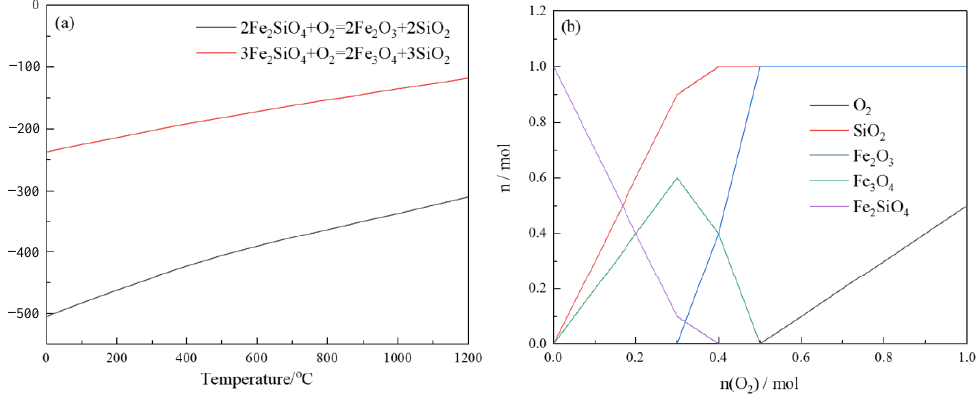
Figure 7. Gibbs free energy curves ( a ) and equilibrium diagram of Fe 2 SiO 4 decomposition ( b ). In order to separate and recover the Fe and iron from the roasted copper slag, alkali leaching of the core pellet was conducted. In the alkali leaching thermodynamics calcula- tion, the degradation amount of SiO 2 was set at 1 mol/kg, oxygen partial pressure was set as the X- axis, and NaOH addition was set as the Y-axis. As shown in Figure 8, when NaOH is added in a small amount, the equilibrium system consists of SiO 2 and NaOH solution, and there is no reaction at equilibrium; notably, the neglect of time in thermody- namics leads to the formation of H 4 SiO 4 in aqueous solution, which is not found in the actual experiment. With the NaOH gradual addition, part of Si reacts with it to form Na 2 Si 2 O 5 , which is completely transformed when the addition amount is 1.5 mol/kg. After addition of NaOH, the reaction products are divided into Na 2 SiO 3 and Na 2 Si 2 O 5 , and the constituents tend towards equilibrium due to the increase in sodium ion concentration. When the amount of NaOH is greater than 2.5 mol/kg, SiO 2 is completely transformed into Na 2 SiO 3 . Thermodynamic analysis shows that the silica-rich phase in roasting copper slag could be leached out by NaOH solution with a certain concentration, the iron-rich phase enters the tail slag, and the silica-rich phase is completely transformed into Na 2 SiO 3 , thus realizing the iron – silicon separation of roasting products.